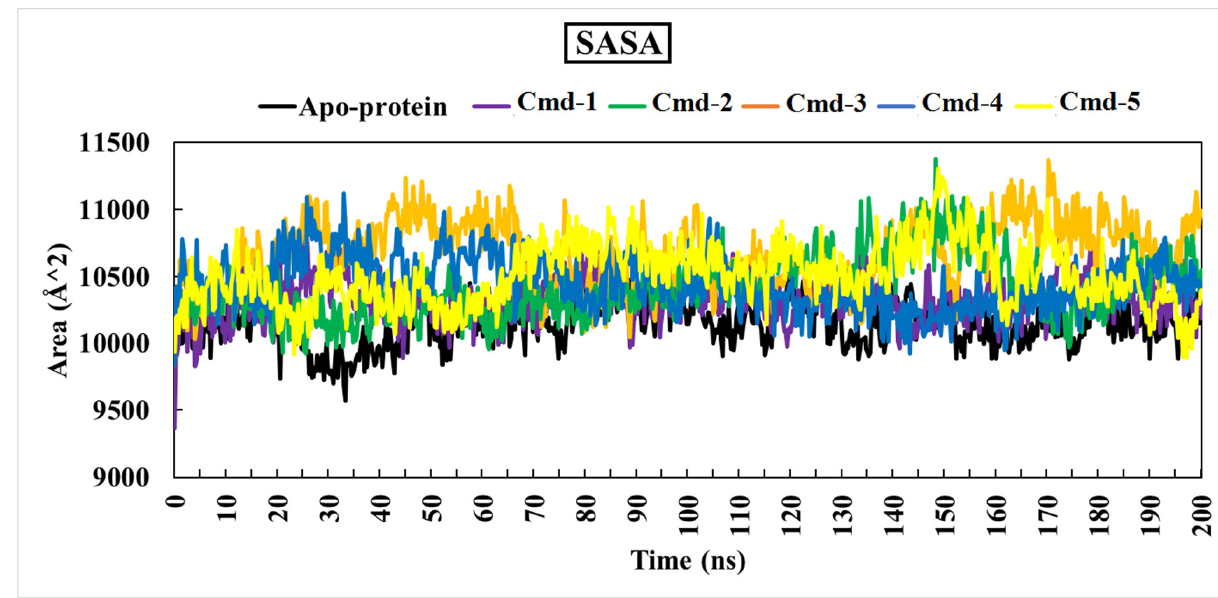
Figure 9. Solvent-accessible surface area (SASA) of apoprotein structure and the best five Cmds for 200 ns MD simulations.